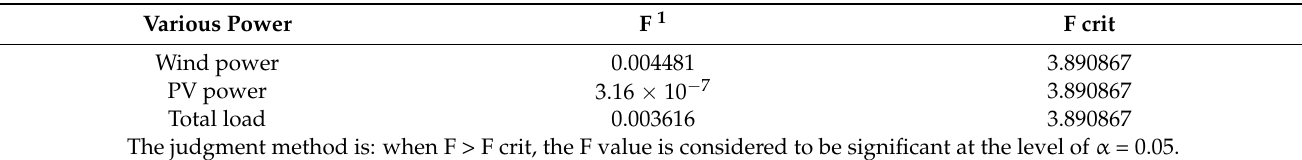
Figure 3. The test results of the wind power, photovoltaic power, and total load power. The MAE indicators (see Figure 3) are all small, indicating that the precision of the prediction model is relatively high. In addition, the difference calculation table of the F test is shown in Table 2. It can be seen that for wind power, F = 0.004481, F crit = 3.890867, F < F crit, indicating that the F value is not significant at the level of α = 0.05. That is, there is no significant difference between the actual value and the predicted value at the level of α = 0.05. Therefore, the prediction results have a high degree of credibility. Similarly, the PV power and total load can be analyzed. Finally, it is concluded that the model trained by the BP neural network has a higher prediction accuracy. To sum up, the prediction accuracy of the MAE and F test is relatively high, indicating that the trained model can be used to predict the power of a certain day in the future. Accordingly, this paper uses the model to predict various power with a time resolution of 15 min of the summer typical day in 2022 of the district, and the prediction results are shown in Figure 4. Table 2. The difference